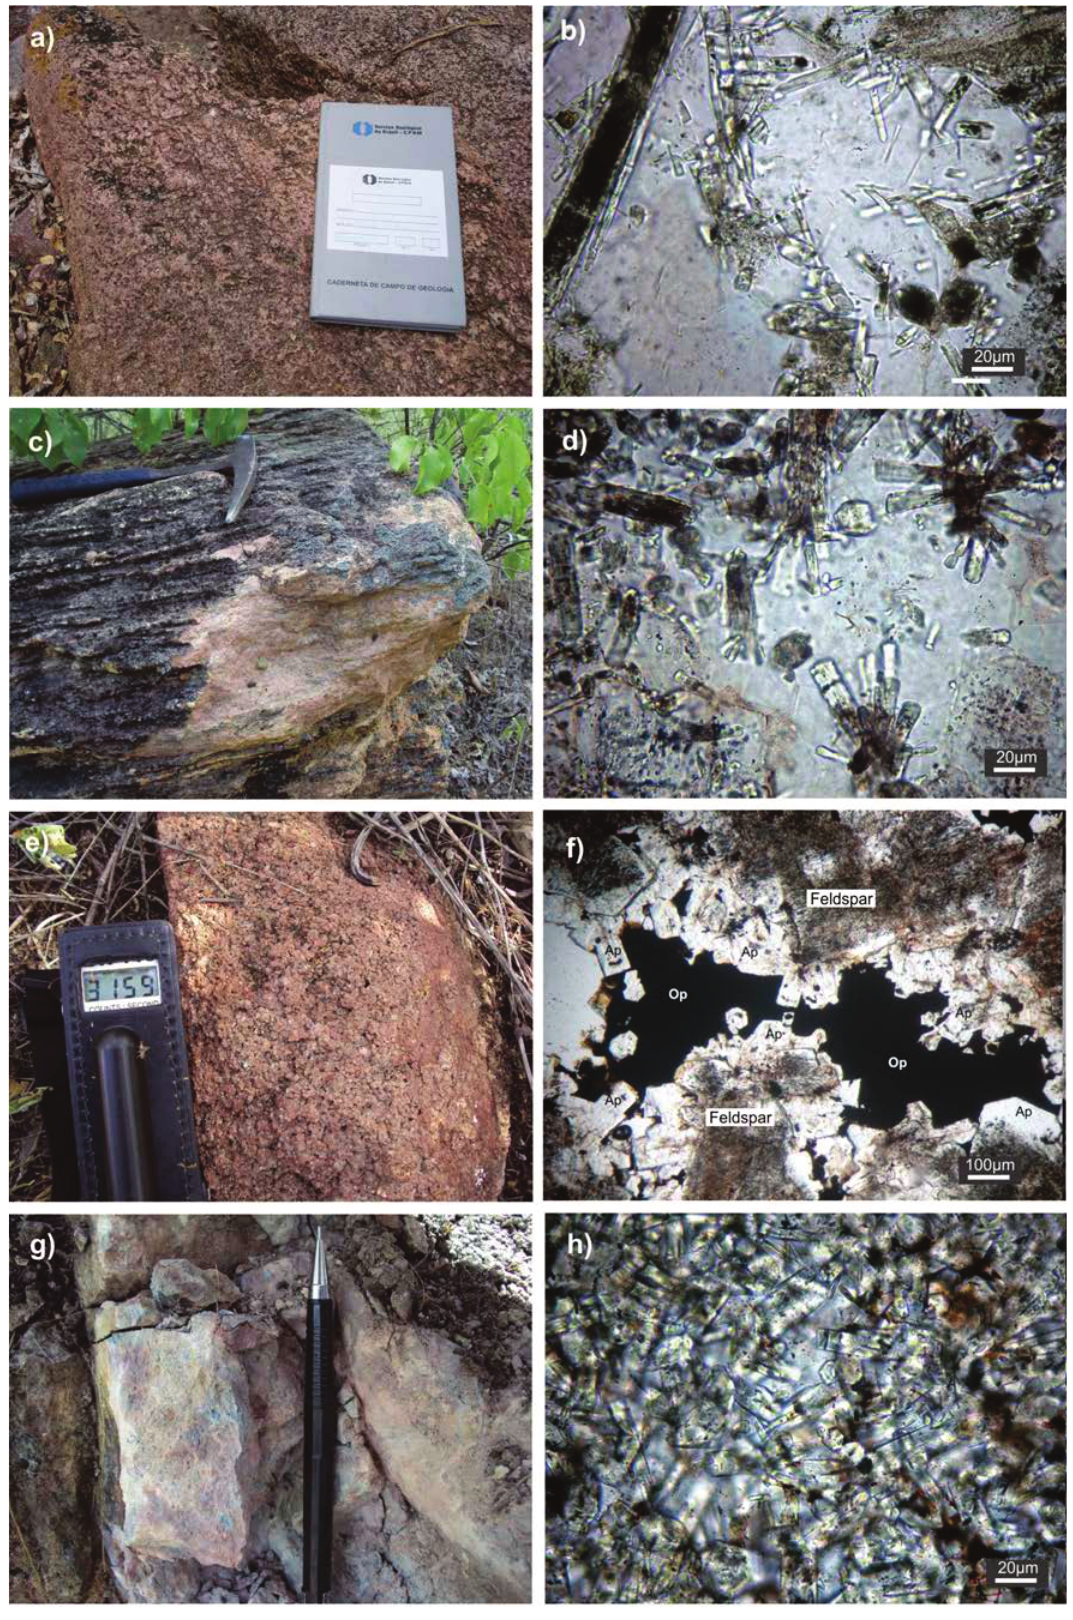
Figure 6 - Photos and photomicrographs showing outcrops and thin section images of U-P occurrences (see Fig. 3): a) outcrop of albitite derived from alteration of granite of the Tamboril-Santa Quitéria Complex; b) albitite in thin section, showing altered albite (in brown color) and apatite impregnated with dark material between the interstices of albite crystals; c) outcrop of albitite derived from alteration of orthogneiss São José de Macaoca; d) thin section showing apatite inclusion in albite; e) outcrop of fine-grained hydrothermal rock derived from alteration of volcanic rocks; f) thin section of fine-grained hydrothermal rock composed mainly of apatite; g) hydrothermal phosphate-rich rock next to mafic dyke; h) thin section showing apatite from hydrothermal phosphate-rich